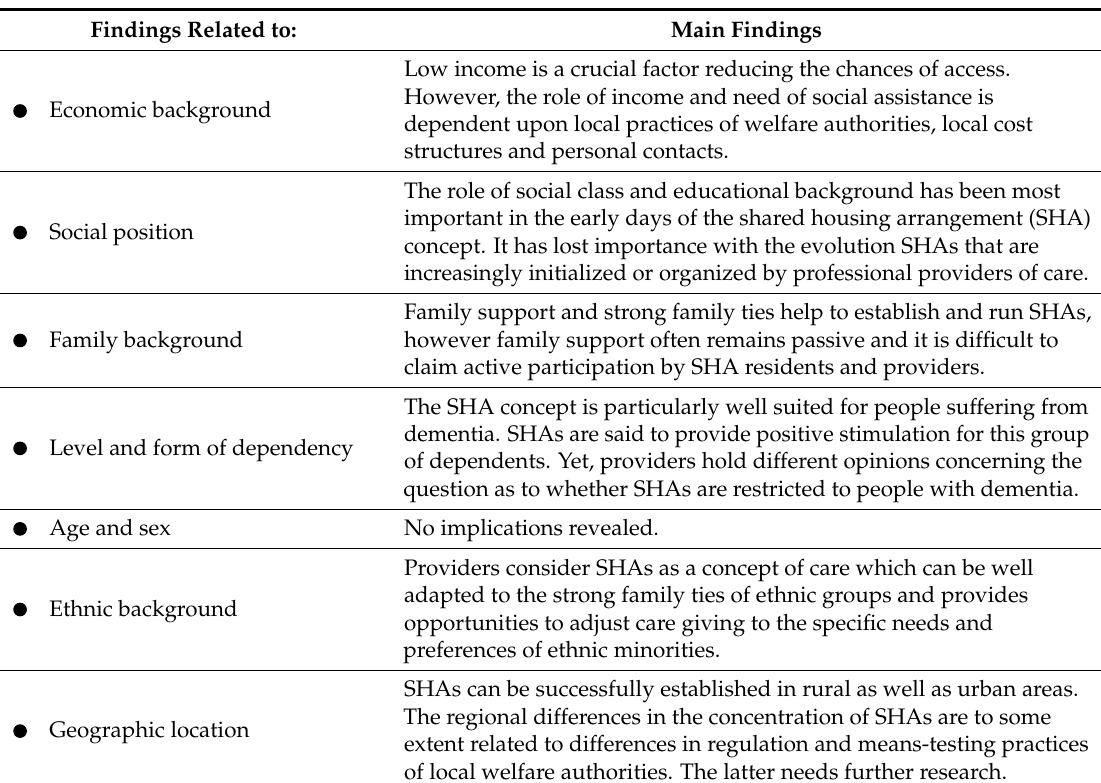
Table 2. Summary of interview